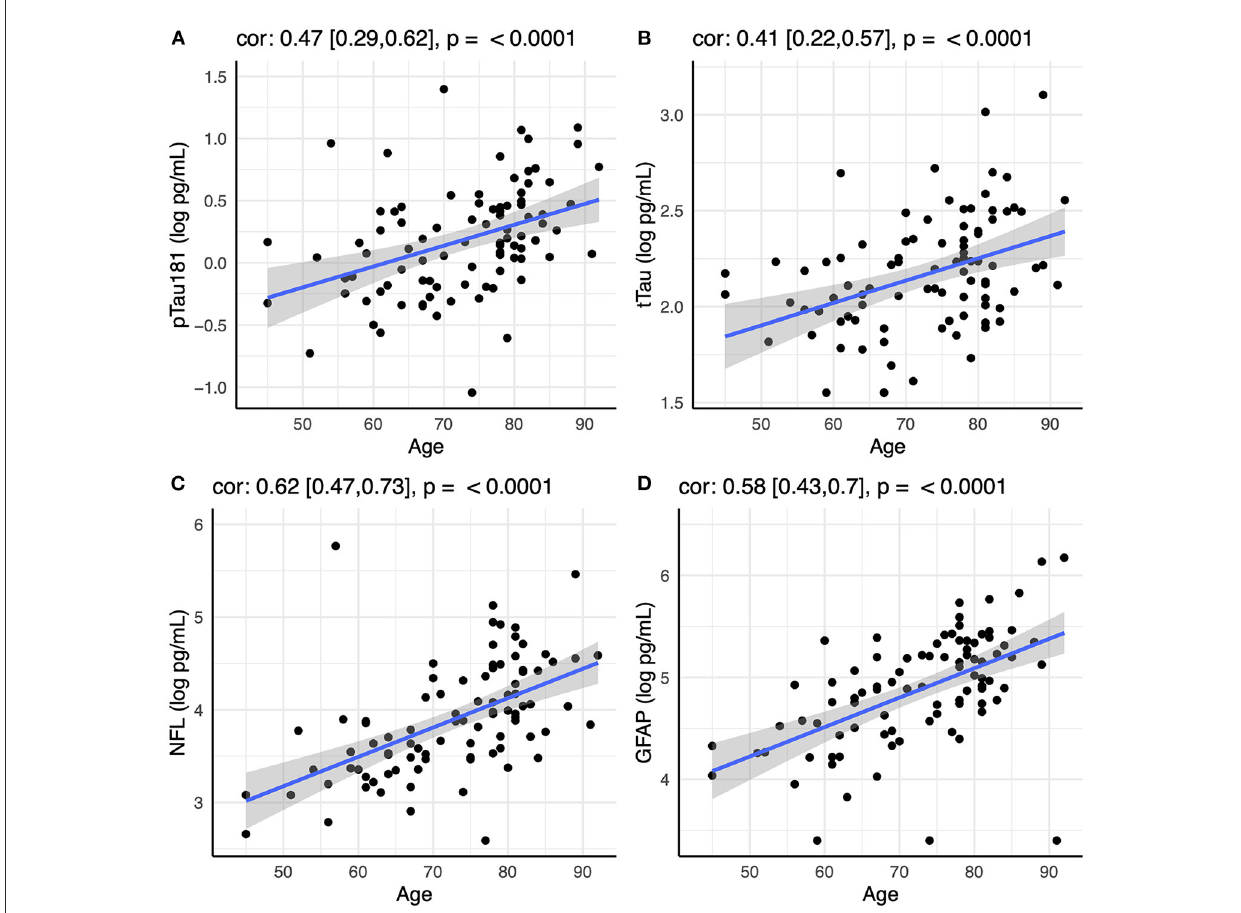
FIGURE1 Correlation between age and plasma levels of (A) pTau181, (B) tTau, (C) NfL, and (D) GFAP using Spearman rank-order correlation. Spearman’s rho with 95% confidence interval and p -values are show on top of each panel.